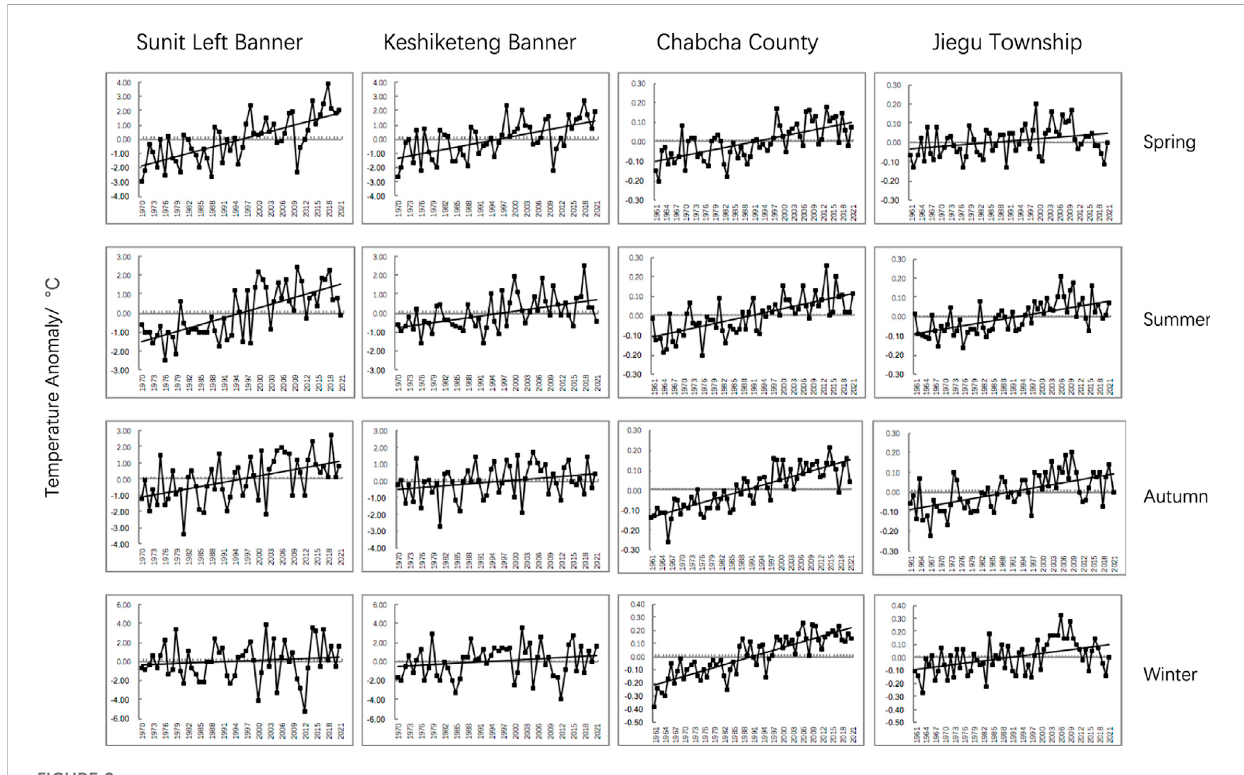
FIGURE 2 Temperature anomaly of four seasons of four cases (1970/1961 –